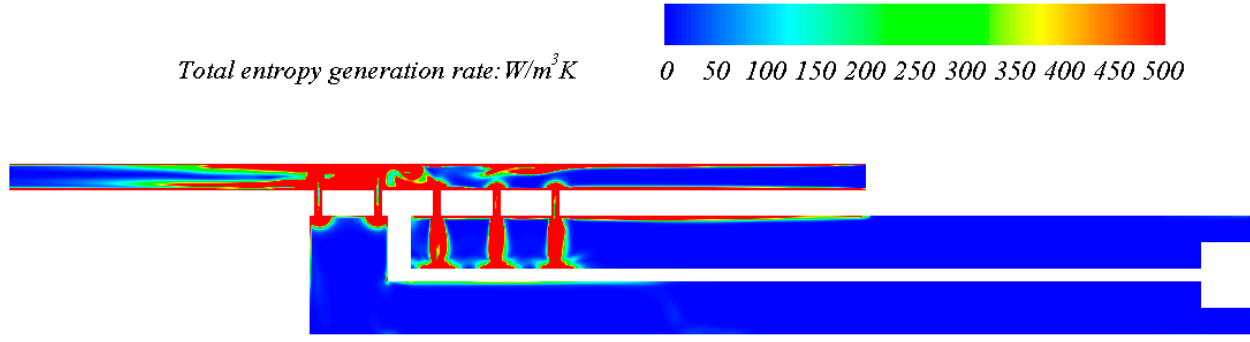
Figure 19. Total entropy generation rate in the fluid domain ( x = 28.5 mm, DSJ off).